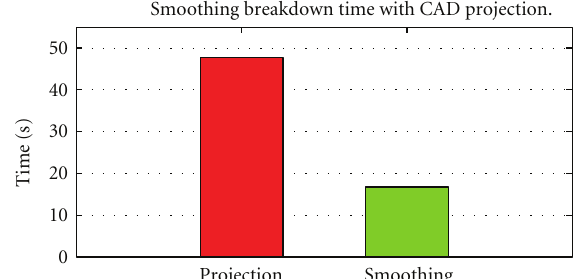
Smoothing breakdown time with CAD projection.